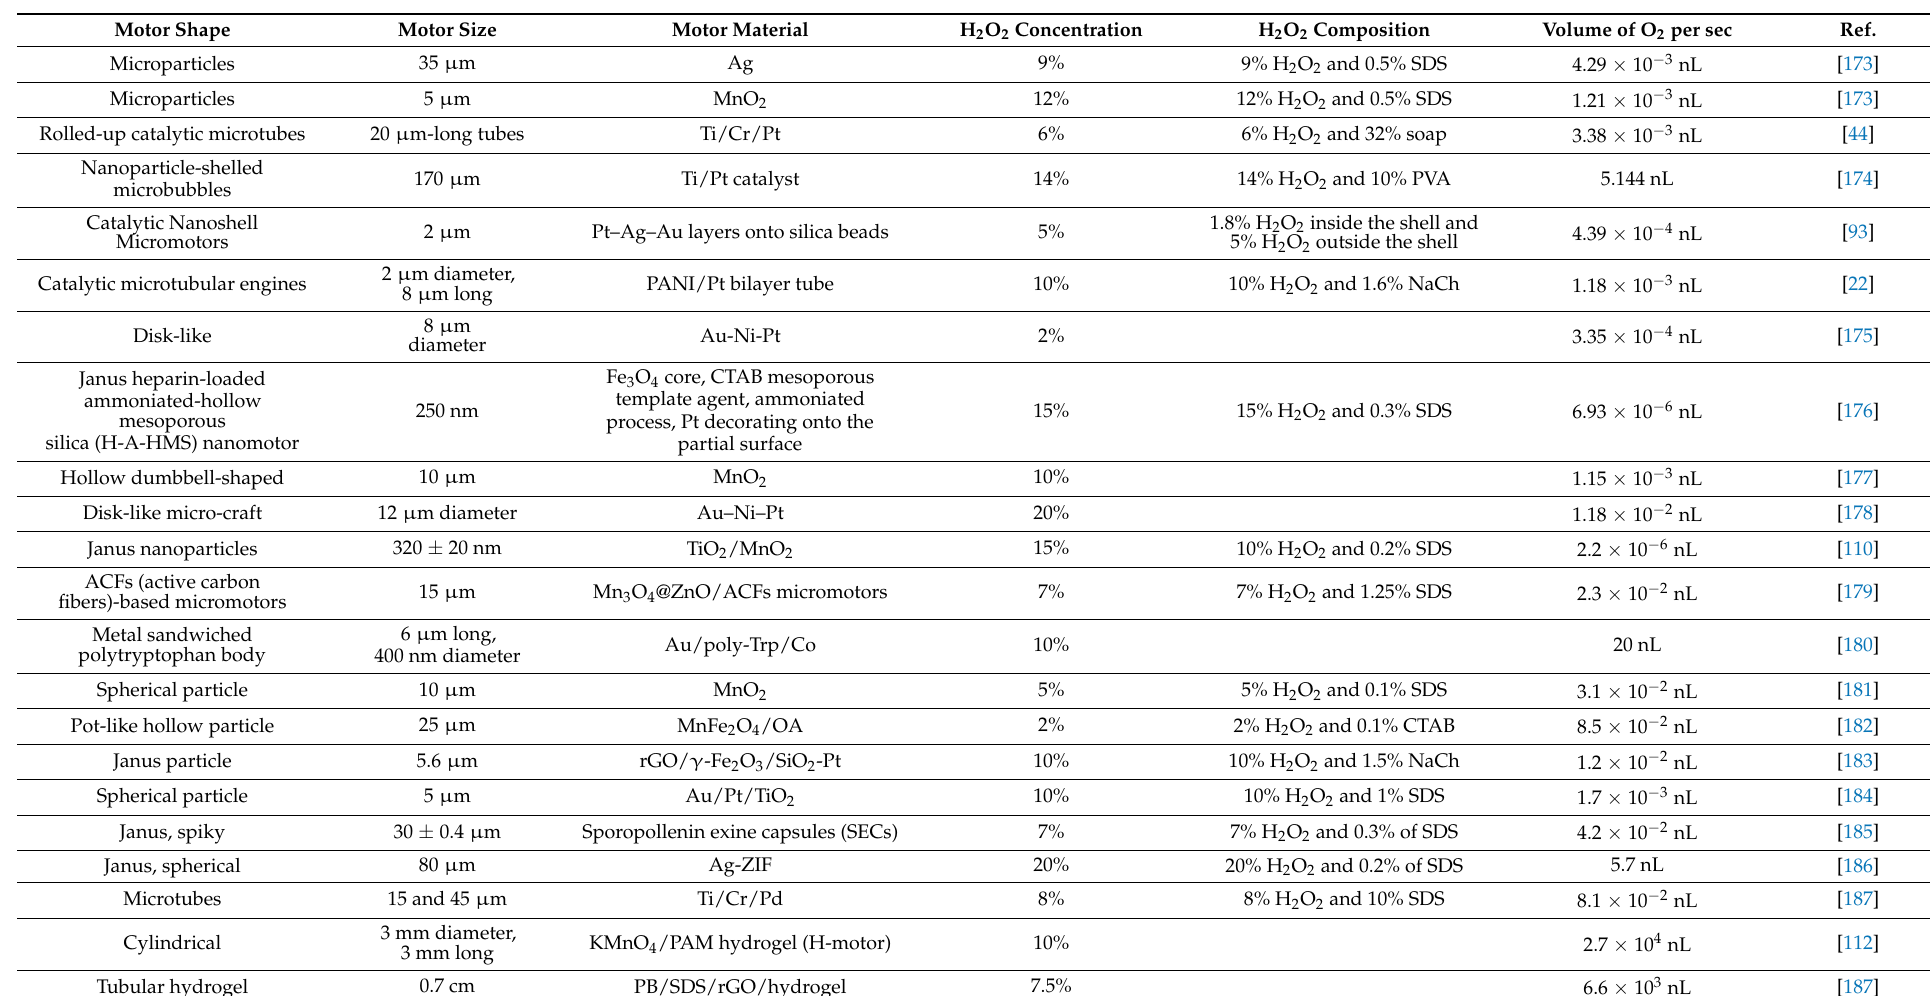
Table 1. Comparison of micro/nanomotor shape, size, material, hydrogen peroxide concentration, hydrogen peroxide composition and volume of generated